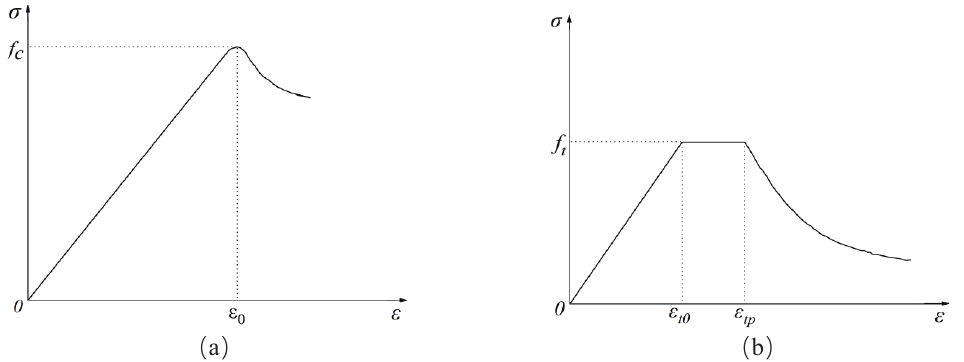
Figure 8. Constitutive relation curve of UHPC: ( a ) stress–strain relation for compression, ( b ) stress–strain relation for